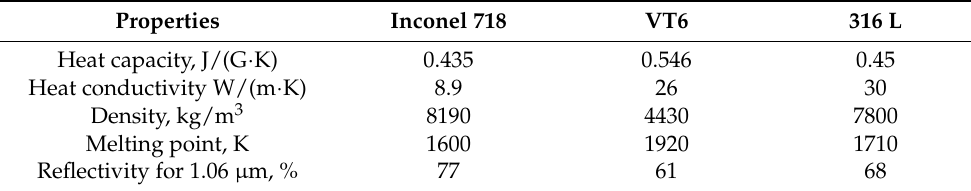
Table 1. Thermophysical and optical properties of the chosen